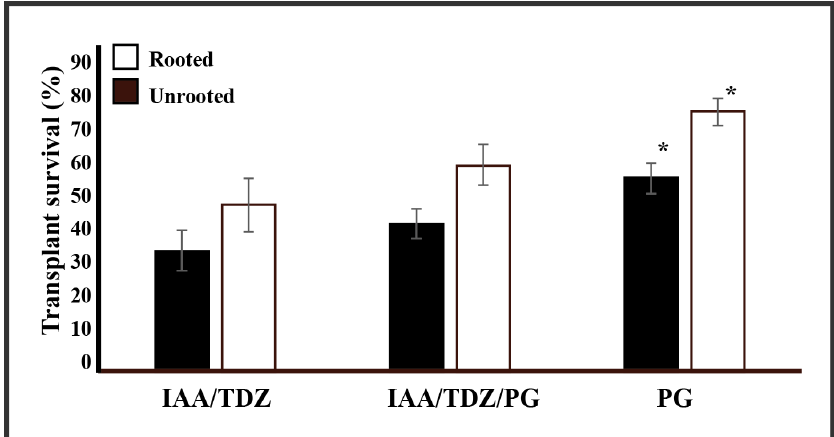
Figure 3. Phloroglucinol-mediated transplant survival rates: the image shows the comparison of survival rates of three hormone treatments derived from rooted and unrooted plant material. * indicates significance at the α value of 0.05.